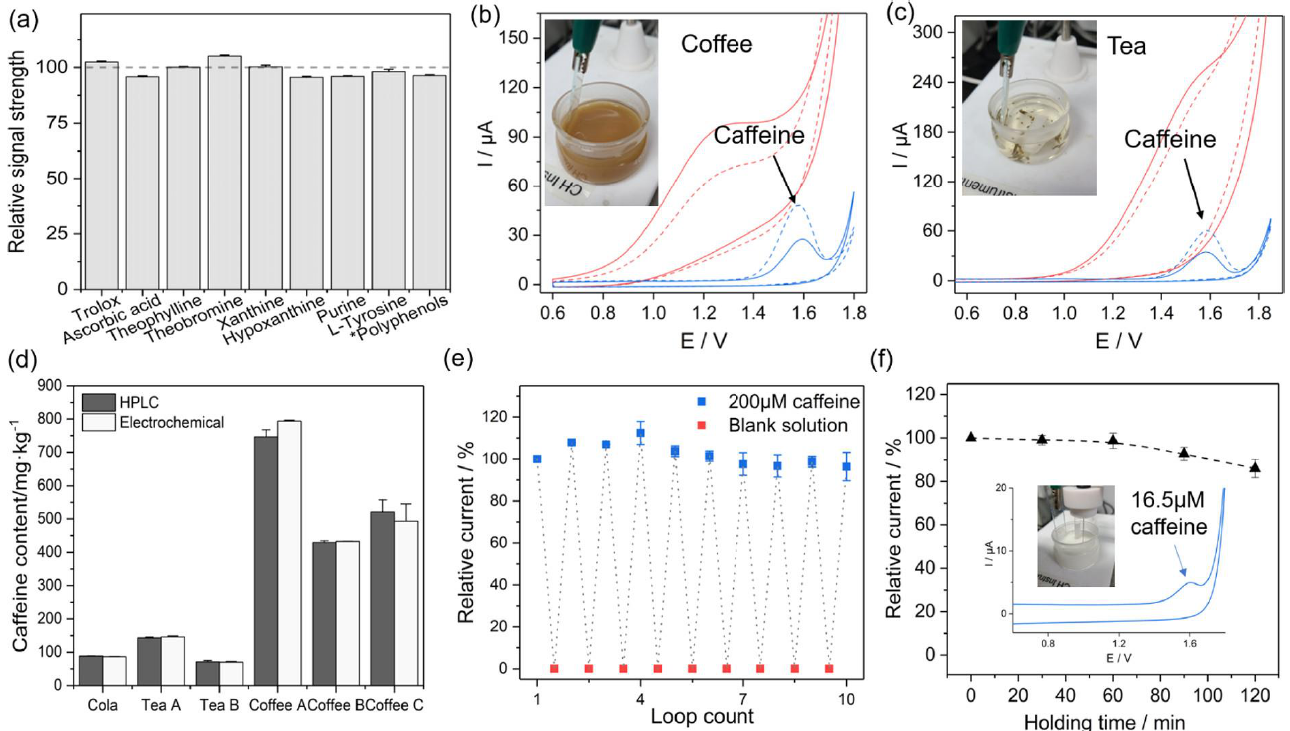
Figure 8. ( a ) Effects of related disruptors on the relative signal strength of caffeine (*: tea polyphenol concentration was calculated with catechin). ( b , c ) Cyclic voltammograms of the SNM/ITO (red) and p -PDMS/SNM/ITO (blue) in unprocessed coffee ( b ) and tea ( c ). To confirm the peak arising from caffeine, the CV curve was recorded before (solid line) and after (dashed line) caffeine’s addition. ( d ) Comparison of the Chinese national standard method and electrochemical method with respect to the detection of caffeine content in several commercially available foods. ( e ) Alternatively, CV scanning in 200 µ M caffeine solution and blank solution. ( f ) Response of DPV current intensity to immersion time in milk with 16.5 µ M caffeine. Inset: CV curve of p -PDMS/SNM/ITO in milk with 16.5 µ M caffeine. Interference-free Detection of Caffeine in Complex Matrices Using a Nanochannel Electrode Modified with Binary Hydrophilic–Hydrophobic PDMS. Reprinted with permission from {Li, Y.; Luo, Z.; Li, G.; Belwal, T.; Li, L.; Xu, Y.; Su, B.; Lin, X. Interference-free Detection of Caffeine in Complex Matrices Using a Nanochannel Electrode Modified with Binary Hydrophilic − Hydrophobic PDMS. ACS Sens. 2021 , 6 , 1604–1612. https://doi.org/10.1021/acssensors.1c00004}. Copyright {2022} American Chemical Society